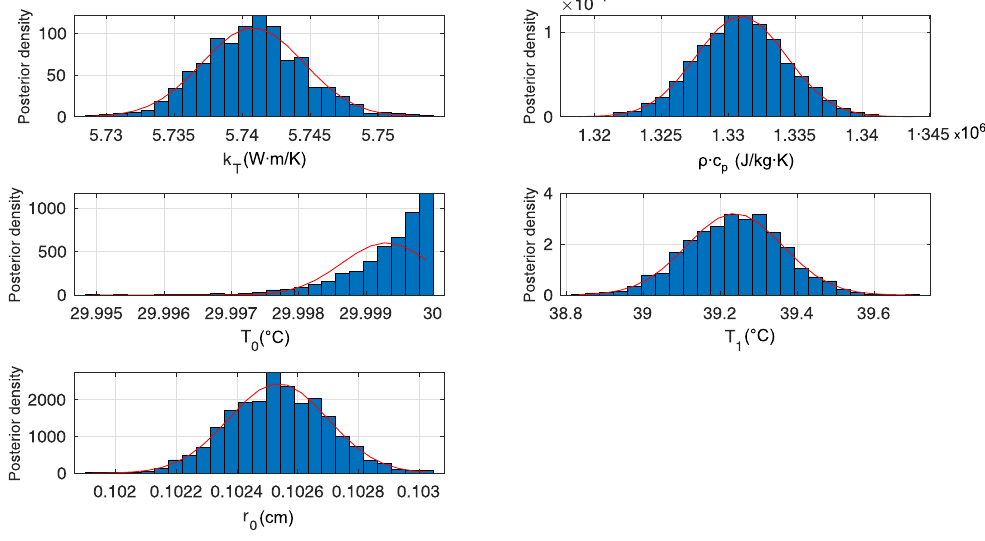
Figure 7. Posterior density estimates for each parameter using DREAM. Applied borehole wall temperature is T 0 + T 1 + 29.5 ◦ C (background). Red curves are best-fit Gaussian, illustrating mean and variance of entire chain;mode (tallest bar in histogram) was used as measure of best